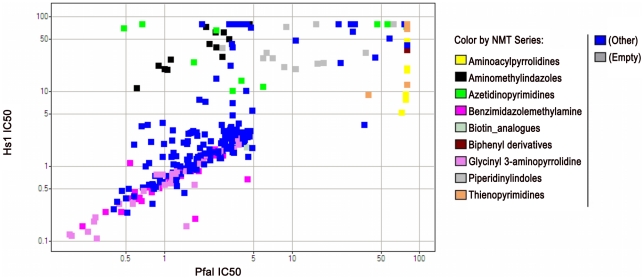
Plot of dose-response activity against Pfal vs. Hs1 NMTs for primary screening hit and analogue screening set.Broader selectivity screening was carried out using 5 NMT orthologues and a set of 2066 compounds. A plot showing the potency of each compound against Pfal and Hs1 showed that most compounds lacked selectivity. All compounds included in the broad selectivity screening were labelled with their chemical series. The series with potential for further follow-up are disclosed in this paper. The other series were discarded due to lack of enzyme activity or NMT-selectivity. Two series stood out from the general trend; representative structures for these series are shown in Figure 5. Two additional series provided potent, non-selective inhibitors, which may also be useful as starting points for medicinal chemistry programs.